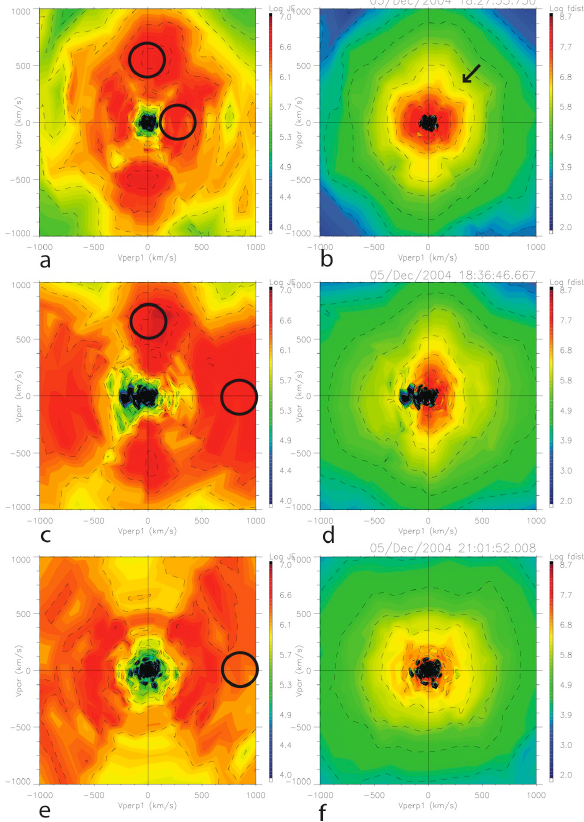
Fig. 2. Double Star 1 ion distribution functions in the form of cuts in the ( V // , V ⊥ ) plane (relative to the magnetic field). The times at which these distributions were sampled are shown with arrows in Fig. 1. Note that these plots are zooms which show the distribu- tions only for ion speeds up to 1000km/s. The right-hand column shows ion distribution functions in phase space density units (PSD) (s 3 km − 6 ) , while the left-hand column shows the same distributions in energy flux units (JE) (keVcm − 2 s − 1 sr − 1 keV − 1 ). The circles in (a) , (c) and (e) , and the arrow in (b) are used to emphasize parts of the distribution discussed in the text.